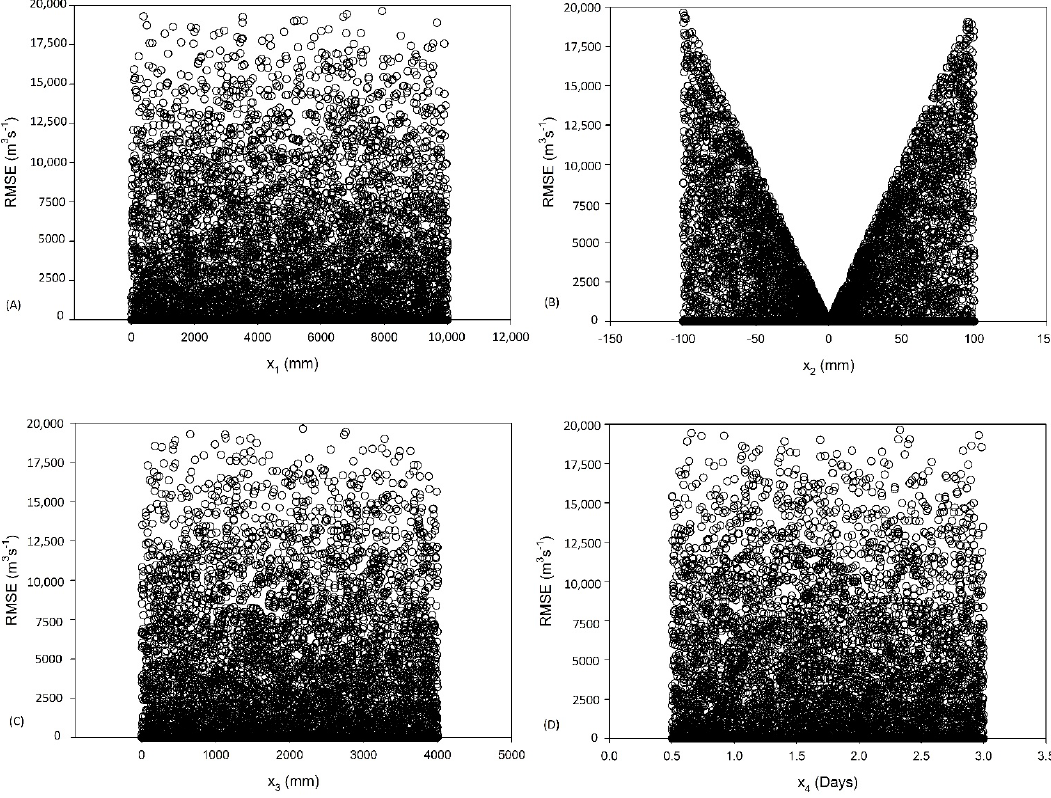
Figure A2. Scatter plots between the RMSE efficiency statistic ( Y -axis) and the parameter values: ( A ) X 1 , ( B ) X 2 , ( C ) X 3 , ( D ) X 4 and ( E ) X 5 , for the GR5J hydrological model.